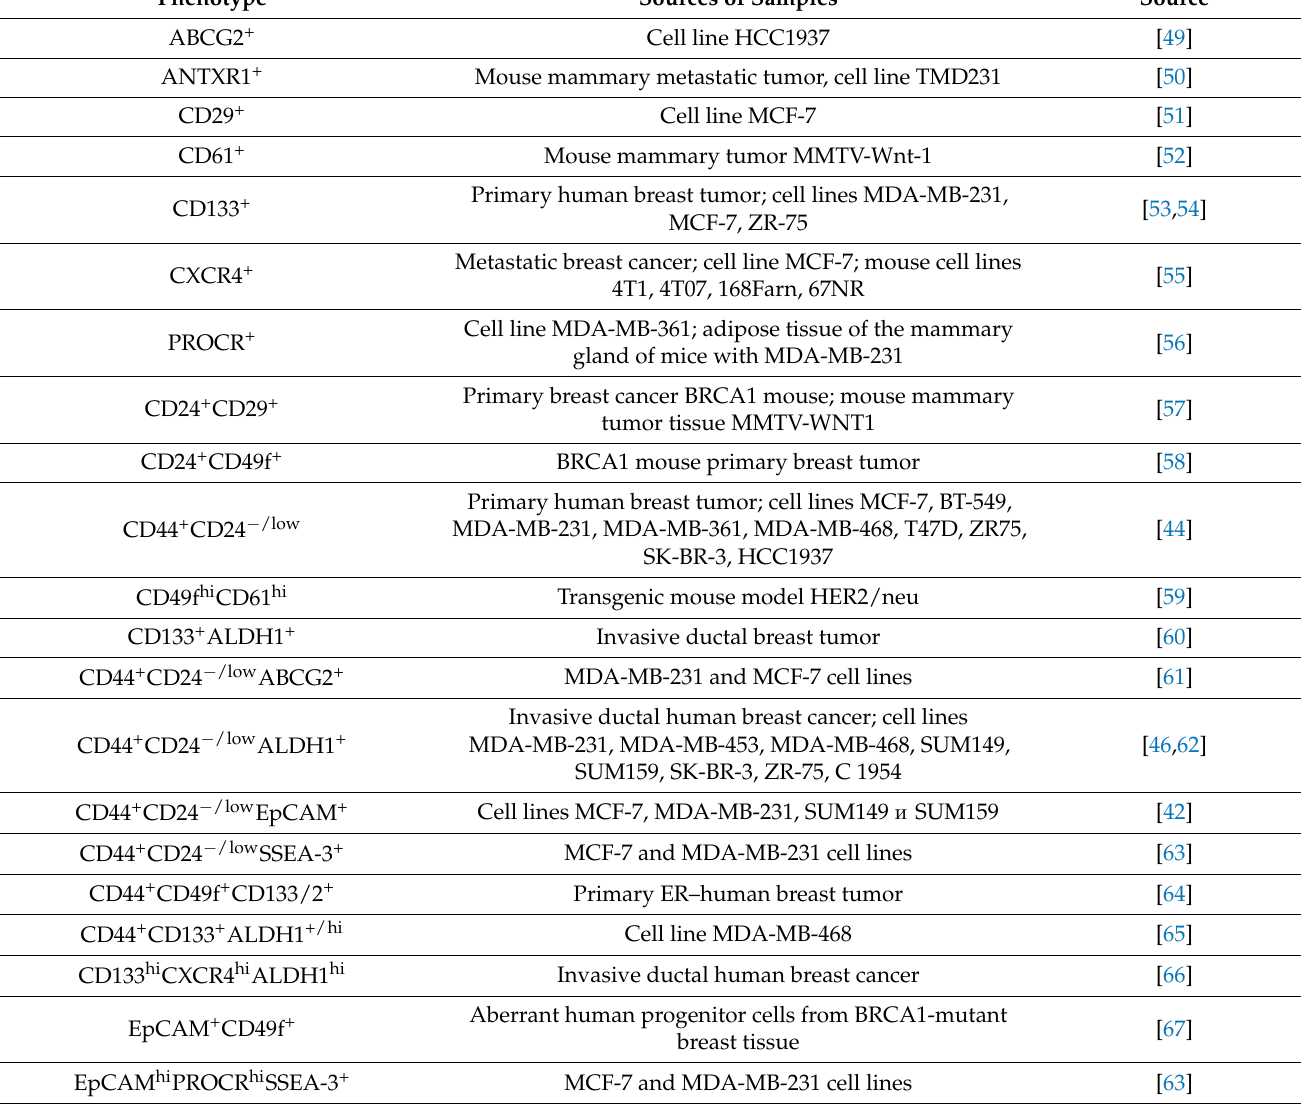
Table 1. Possible CSC phenotypes of breast cancer according to the literature